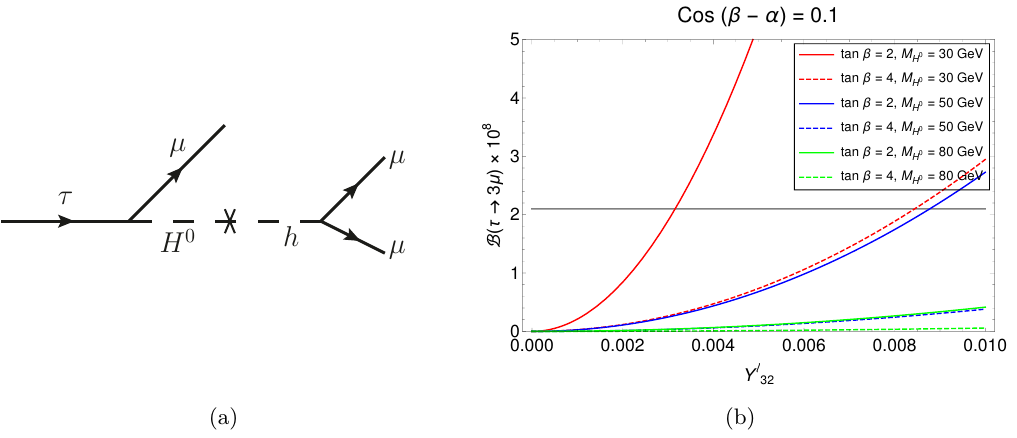
Figure 24 . (a) Higgs mediated diagram contributing to τ → 3 µ process. (b) Variation of B τ with the coupling Y ‘ for different values of tan β and M . The constraint cos ( β − α ) = 0 . 1 has been H 0 32 used while calculating the branching fraction. The gray line denotes the experimental upper bound on the branching